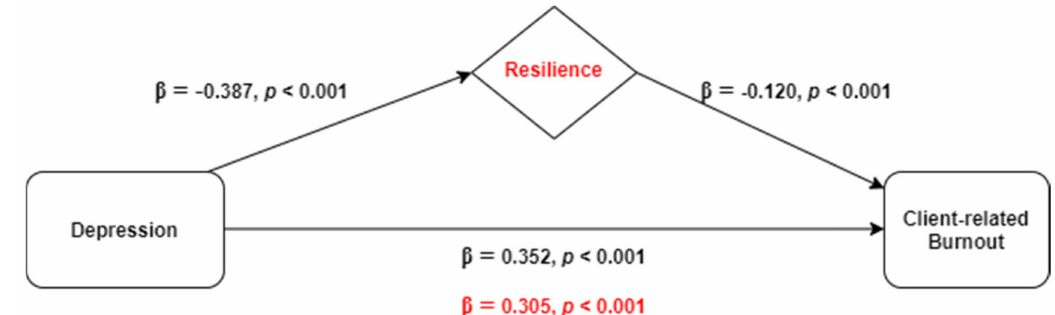
Figure 3. Representative scheme of the mediating role of resilience in the relationship between depression and client-related burnout. Changes in beta weights when the mediator is present are highlighted in